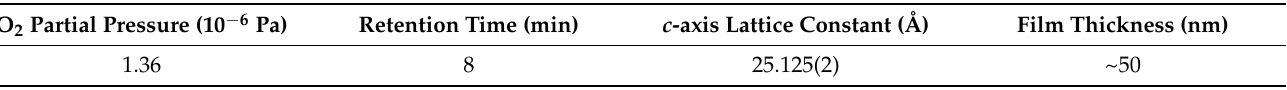
Table 1. Experimental conditions for sputtering and the structural parameters of the fabricated YbFe 2 O 4 thin film.